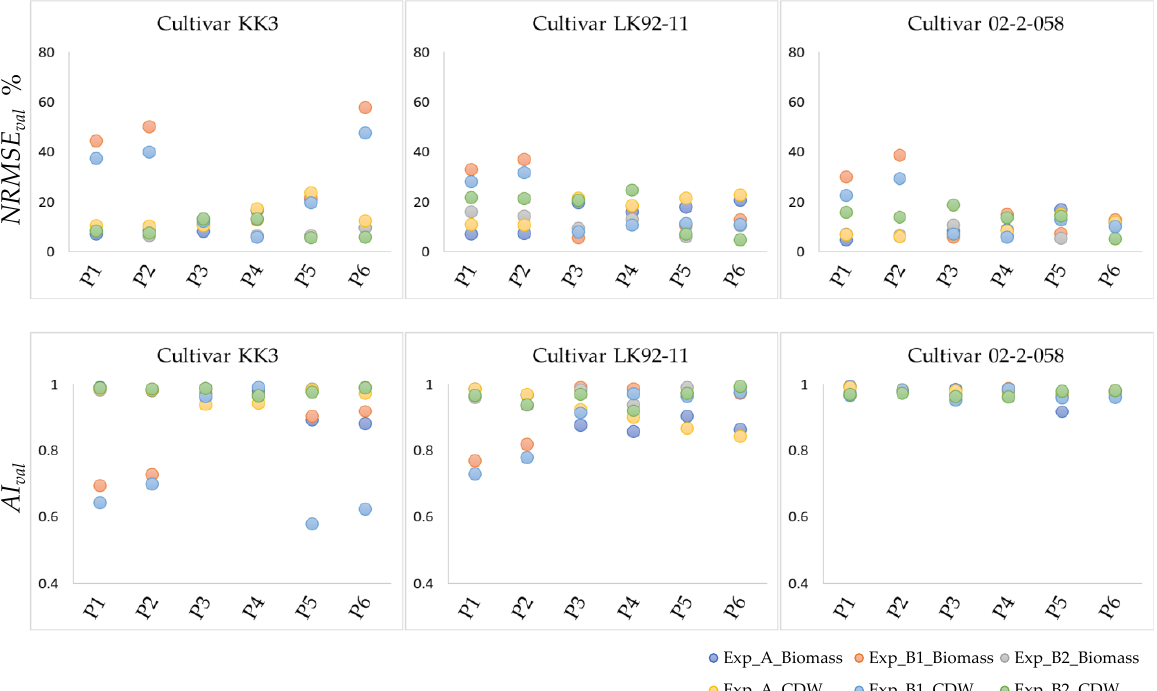
Figure 7. Box plots of R 2 values obtained during the validation of the parameter ensembles (P1, P2, P3, P4, P5 and P6) under each experimental condition corresponding to cultivars ( a ) KK3, ( b ) LK92-11, and ( c ) 02-2-058. Each parameter ensemble of the box plots indicated R 2 values calculated between observed and simulated yields for six different cases (A_Biomass, A_CDW, B1_Biomass, B1_CDW, B2_Biomass, and B2_CDW) of a single cultivar (see Figure 2 for more details). The median is indicated by thick black lines, the interquartile range (IQR) is indicated by the boxes, 1.5 times the IQR is indicated by the whiskers, and the outliers beyond 1.5 times the IQR are indicated by points in black color.